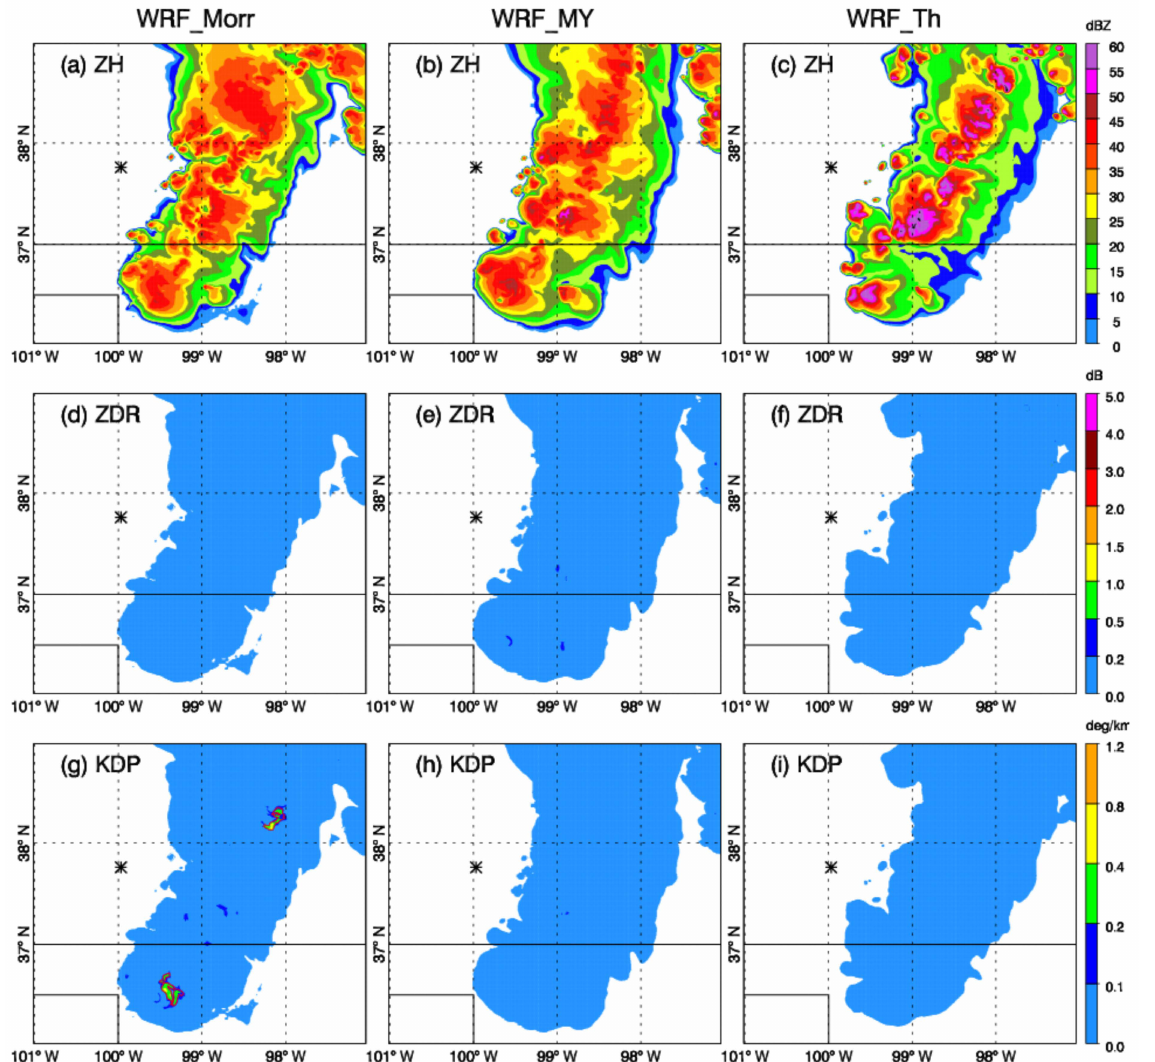
Figure 11. Z H ( a – c ), Z DR ( d – f ), and K DP ( g – i ) for WRF_Morr, WRF_MY, and WRF_Th, respectively. Red contour lines in K DP plot show the rain water mixing ratio of 0.5 g kg − 1 . All plots are for the fields at 2345 UTC 29 May 2018 at 8 km height. The star signs in the plots show the location of the KDDC